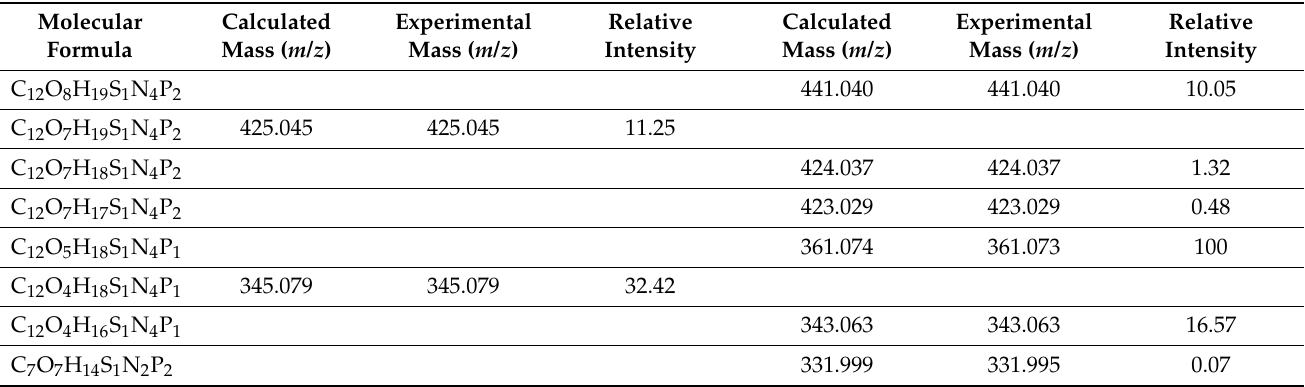
Table 4. MS/MS fragments of ThDP and